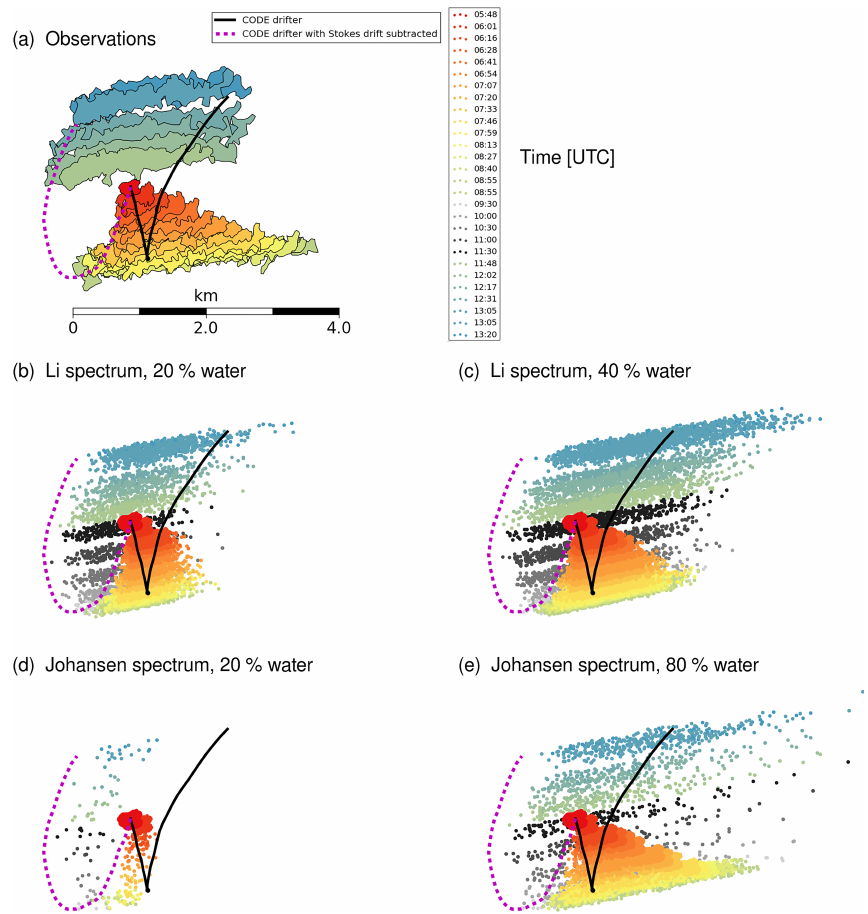
Figure 1. (a) Oil slick contours observed from UAVSAR. (b) Modeled oil slick contours using droplet size spectra from Li et al. (2017b), with a water content of 20%. (c) Same as (b) , but with a water content of 40%. (d) Modeled oil slick contours using droplet size spectra from Johansen et al. (2015), with a water content of 20%. (e) Same as (d) , but with a water content of 80%. Only modeled oil elements at the ocean surface are shown here for direct comparison with the observations. The black line denotes the trajectory of a CODE drifter. The dashed magenta line is a progressive vector diagram of the CODE drifter velocities with the Stokes drift from the operational wave model subtracted. This velocity is used for the oil drift simulations. During an intermittent time period, shown with gray contours in (b) – (e) , no images were taken because the aircraft left the site to refuel. Table 1. Oil types used for the oil spill transport simulation of spills off the coast of western Norway. Visund and Oseberg A represent light- and medium-density oil types that are exploited in the study region. The IFO-180LS is included as an example of heavy oil (bunker oil) used as fuel for